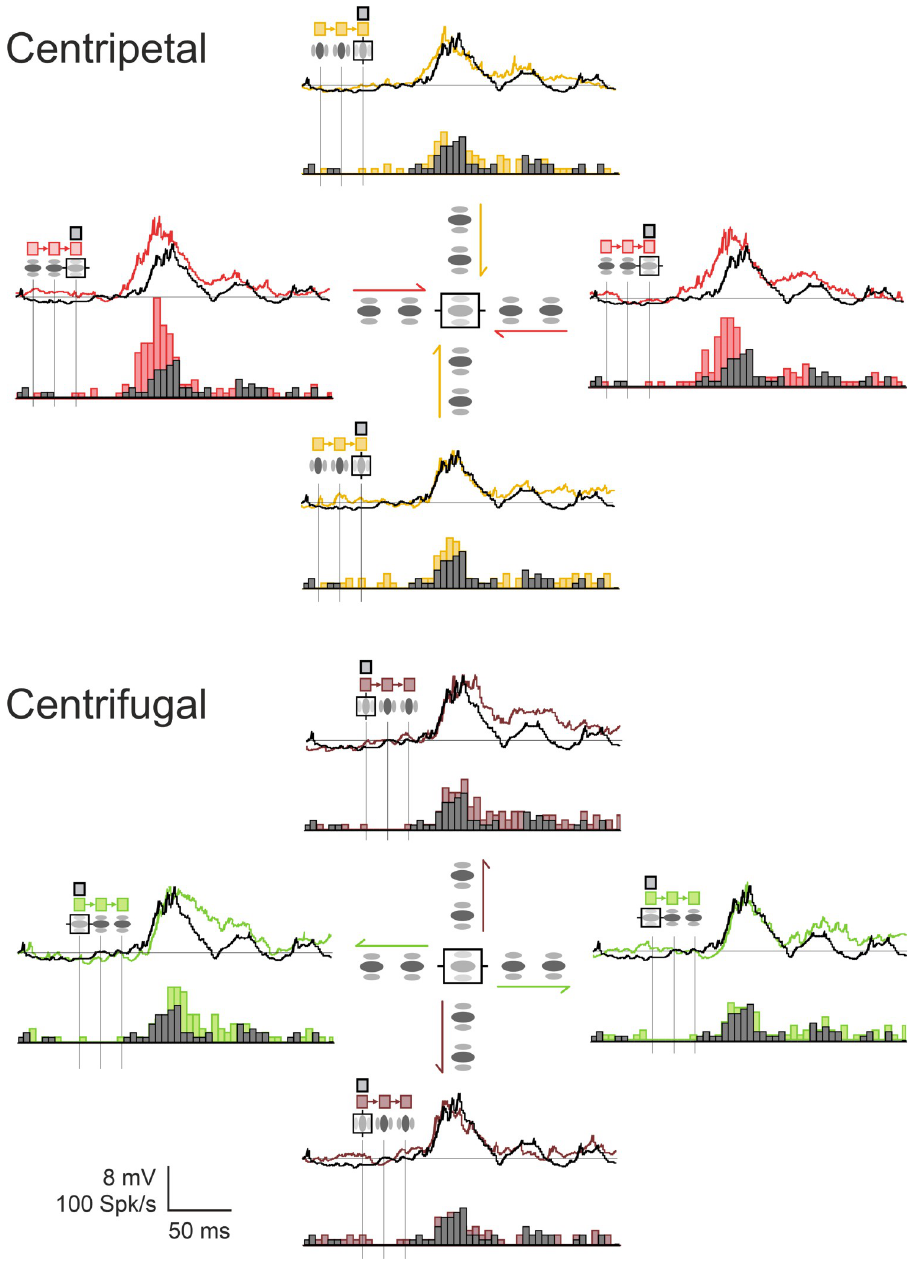
Fig 4. Example of contextual modulation of the Center-response by centripetal and centrifugal AM (“cardinal” protocol). Example of Center-Surround AM responses, compared to the Center-Only condition. The comparison, in the same cell, between centripetal (CP: top panel) and centrifugal (CF: bottom panel) motion flows illustrates the importance of the Surround-then-Center timing in the associative effect. For each configuration, a polar representation of PSTWs (top) and PSTHs (bottom) is shown for the four AM axes. In each central inset, the relative positions of the GP inducers are indicated in relation with the receptive field (rectangle, horizontal for the preferred orientation. The contextual responses are overlaid on the Center-Only stimulation (black). Note that the contextual latency shortening and the spike discharge rate increase of the Center response are observed only in the collinear Centripetal condition (top, red). Color code conventions for AM flow (arrow): CP-ISO-RF: red for centripetal “collinear” along the orientation preference axis; CP-CROSS-RF: gold for centripetal “parallel” across the RF width axis; CF-ISO-RF: green for centrifugal “collinear” along the RF main axis, CF-CROSS-RF: brown for centrifugal “parallel” across the RF width axis. See Text for details.